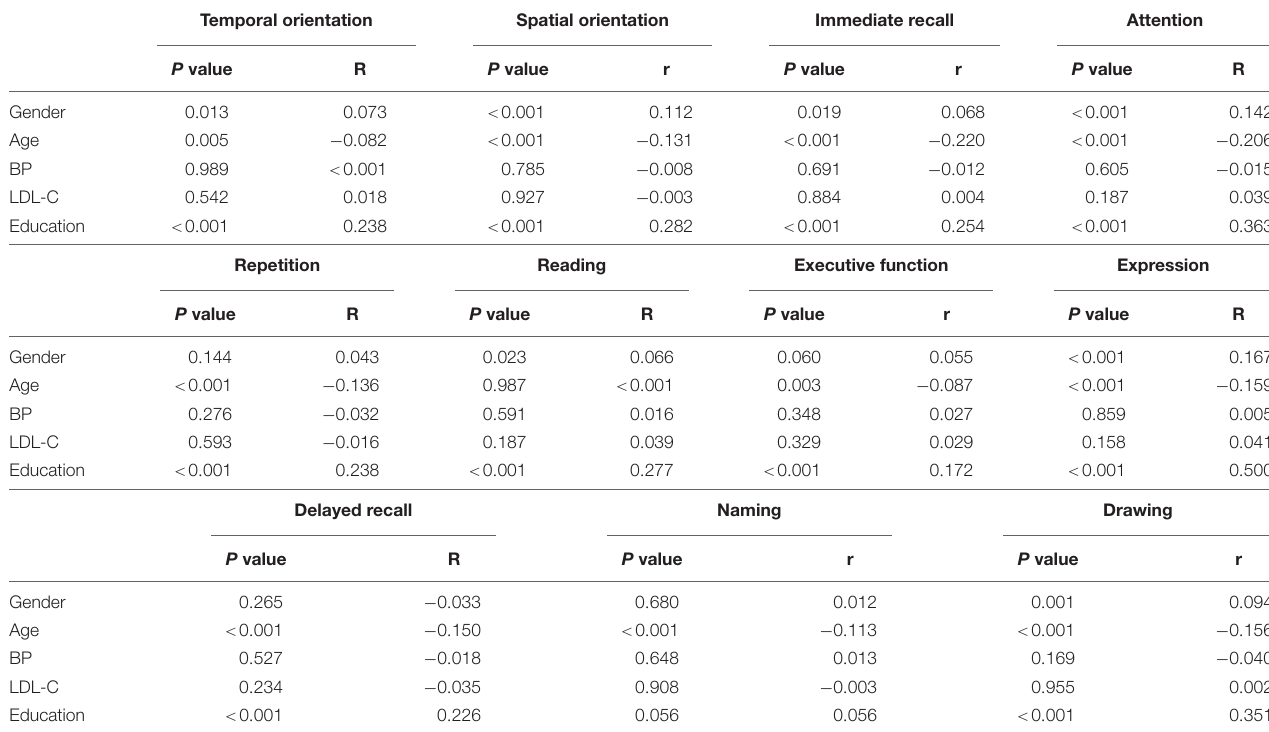
TABLE 3 | Correlation analysis of gender, age, education, blood pressure and low-density lipoprotein cholesterol on 11 sub cognitive domains in Mini-mental State Examination, China, 2016. Temporal